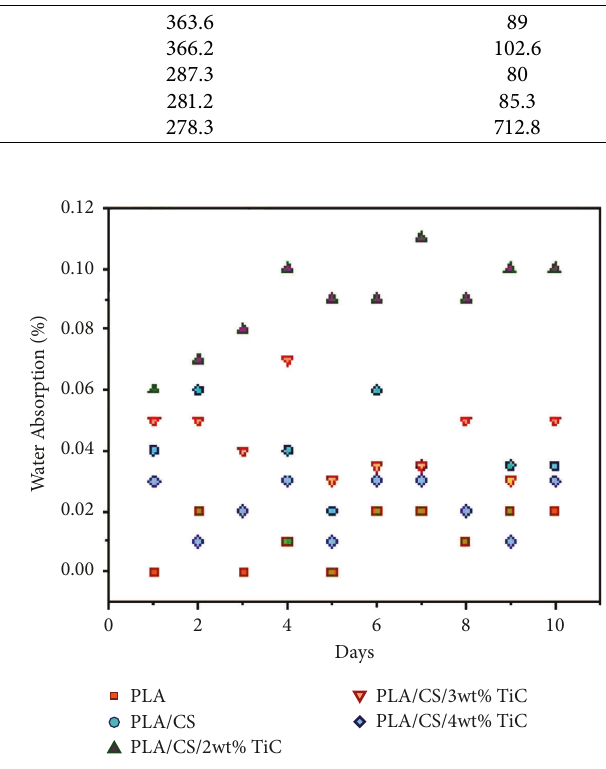
Figure 11: Water absorption behavior for various TiC NP loadings.